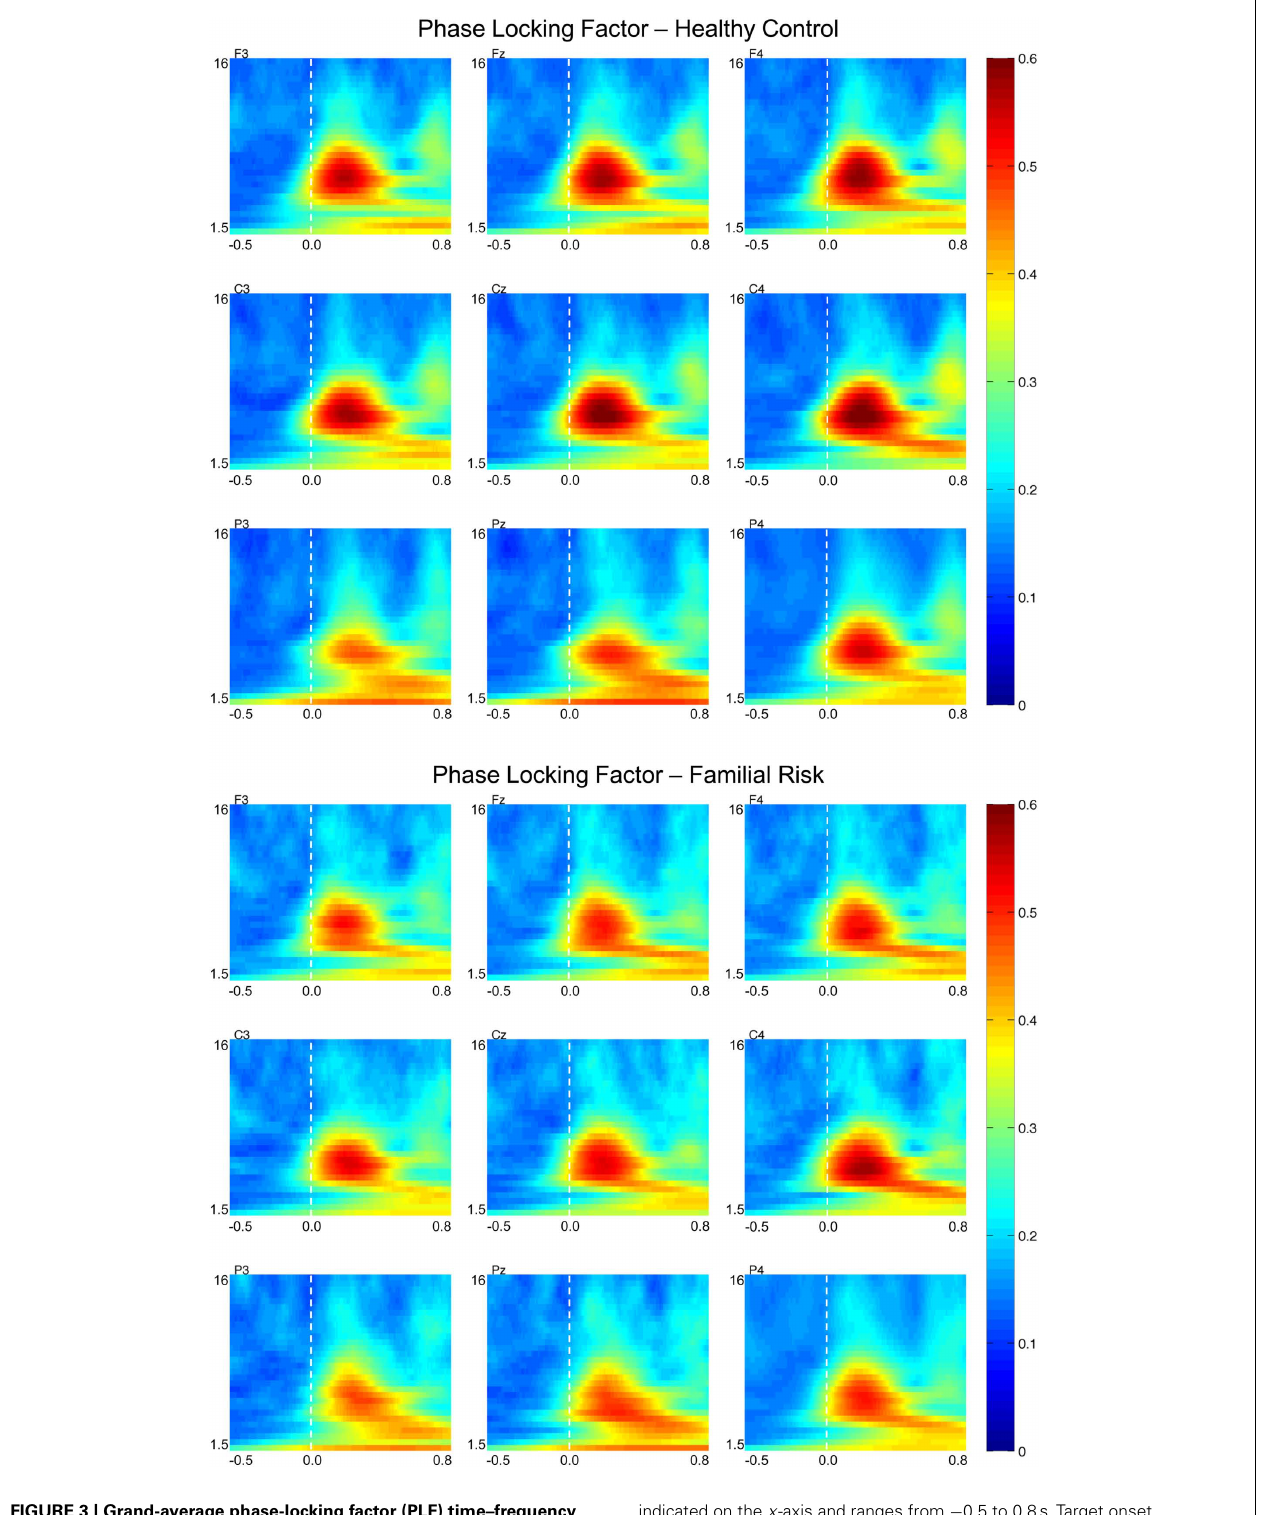
FIGURE 3 | Grand-average phase-locking factor (PLF) time–frequency transformations for healthy control (HC) and familial risk (FR) groups at electrodes F3, Fz, F4, C3, Cz, C4, P3, Pz, and P4. EEG frequency is indicated on the y -axis for all panels ranging from 1.5Hz to 16Hz.Time is